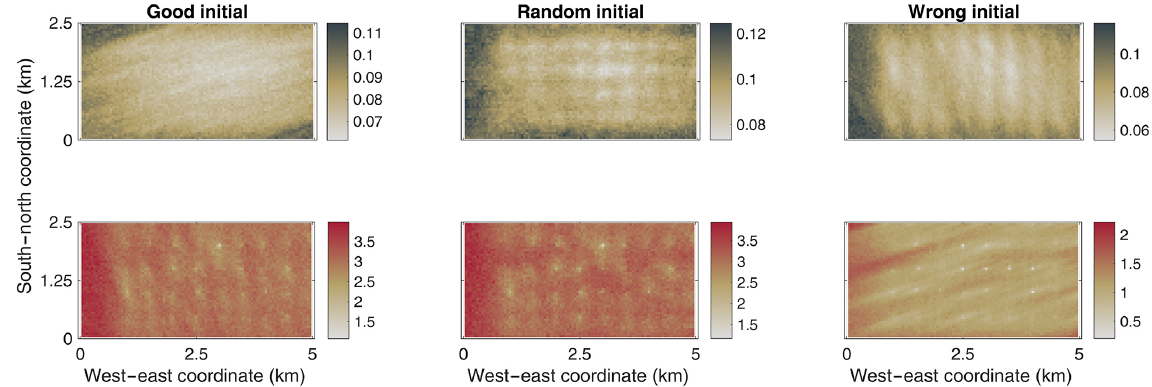
Figure 6. Joint estimation of recharge (top row panels) and conductivity (bottom row panels). Shown is the final ensemble variance after all assimilation